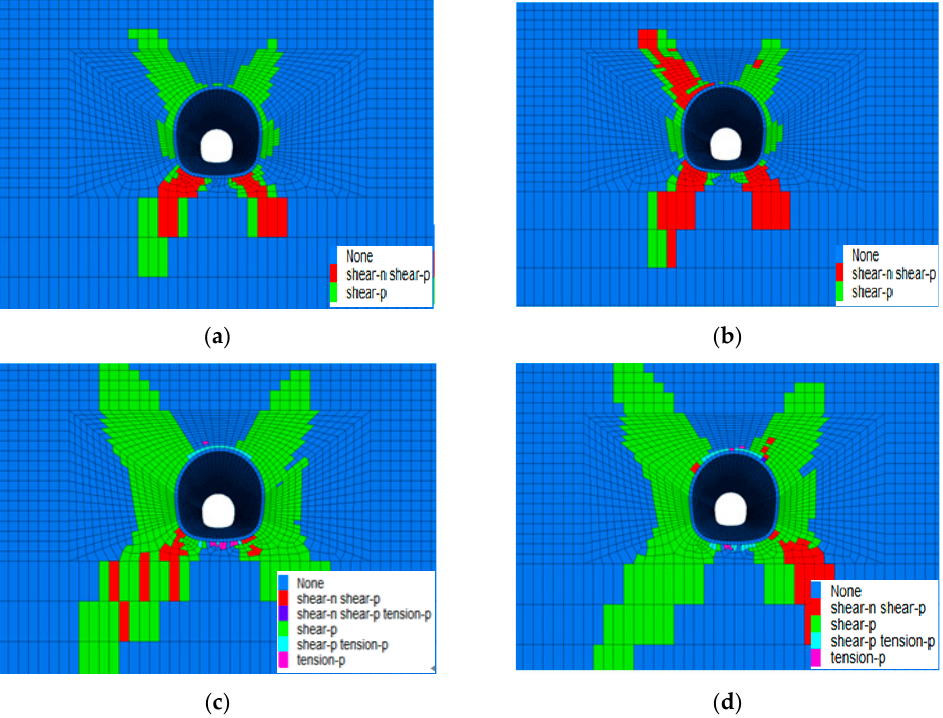
Figure 6. Plastic differentiation layout under various working conditions. ( a ) 1 m. ( b ) 1.5 m. ( c ) 2.0